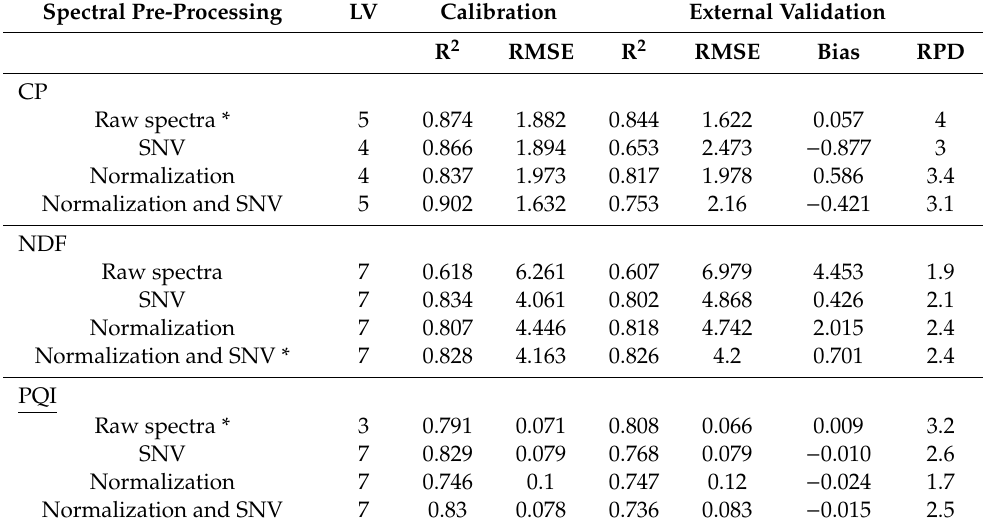
Table 3. Statistics for calibration and external validation models for CP, NDF, and the PQI using near-infrared spectroscopy (NIRS) spectra and partial least squares regression (PLSR) Spectral